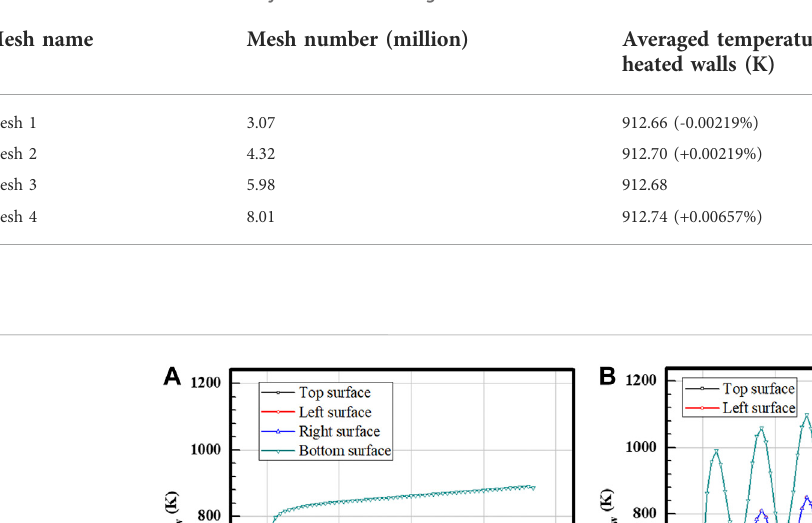
TABLE 2 Related data calculated by different mesh regimes.